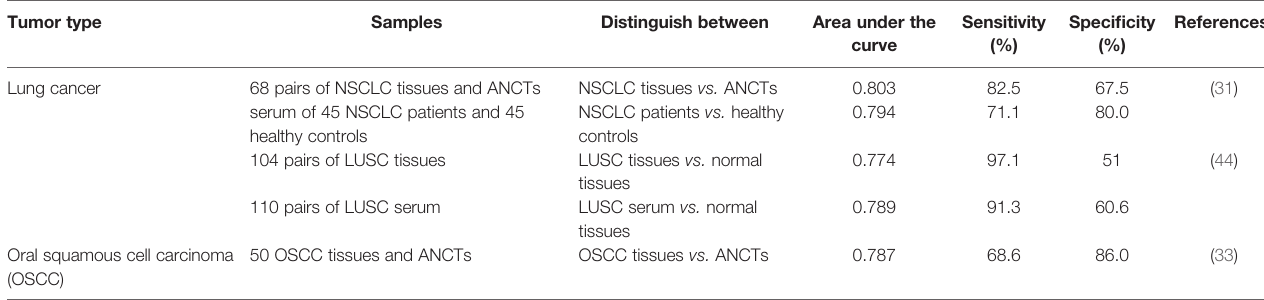
TABLE 4 | Diagnostic value of circPVT1 in